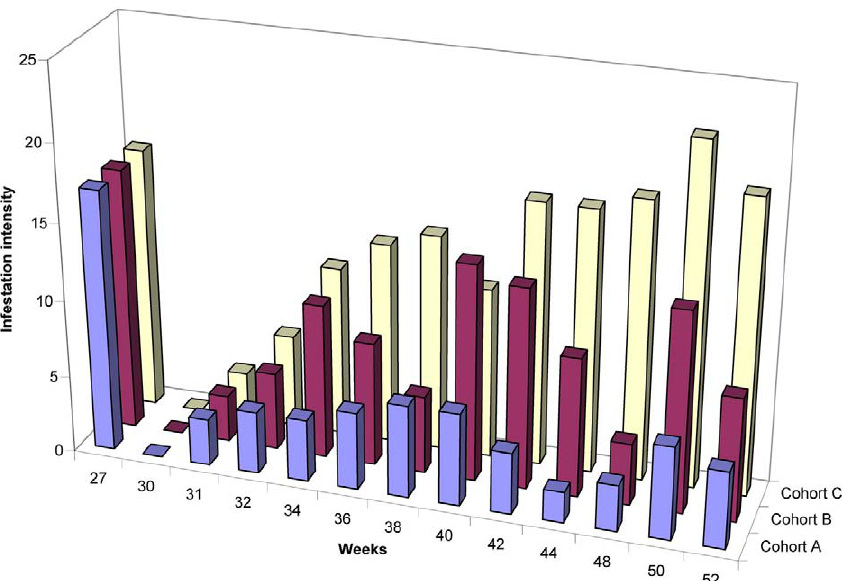
Figure 2. Intensity of infestation (Stage I-IV + manipulated lesions) during the whole study period. The data indicate the number of median lesions per individual. No follow-ups were carried out between calendar weeks 45–47 (see Materials and